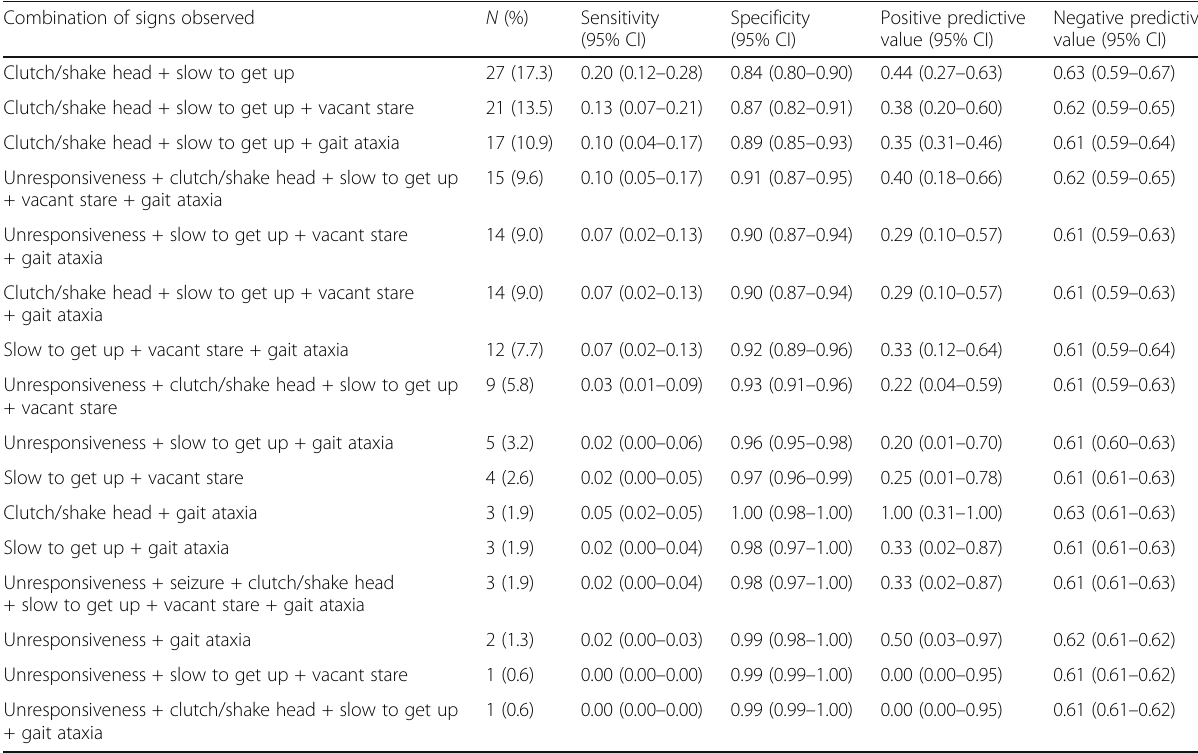
Table 2 Frequency, sensitivity, specificity, positive predictive value, and negative predictive value of the different combinations of signs demonstrated during the study period Combination of signs